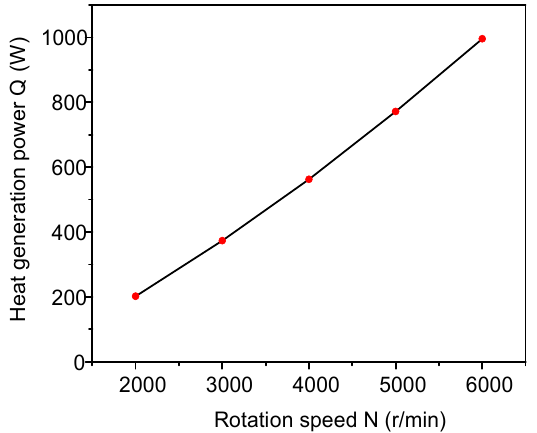
Figure 4. Variation in heat generation power with rotation speed.